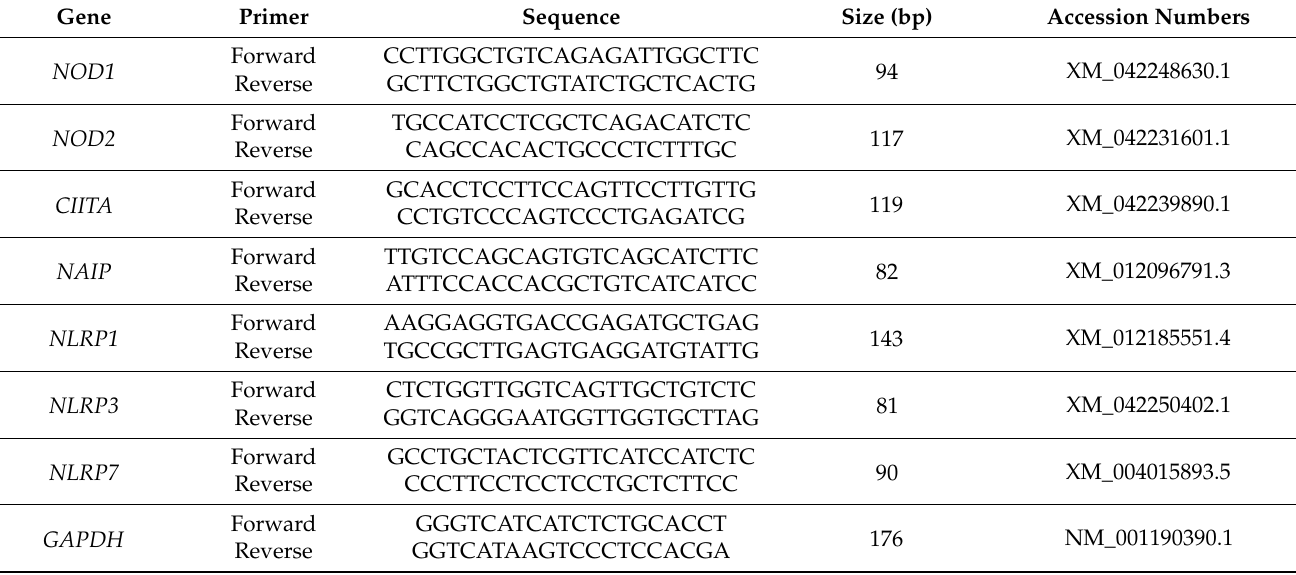
Table 1. Primers used for